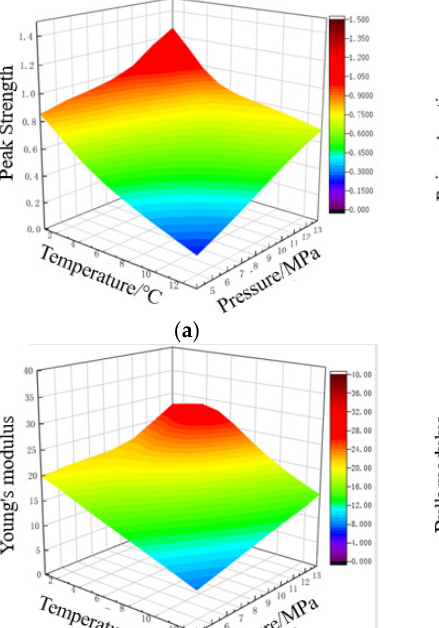
Figure 14. Variation of mechanical properties of sandy hydrate with temperature and pressure ( a ) Peak Strength; ( b ) Poisson’s ratio; ( c ) Young’s modulus; ( d ) Bulk modulus.